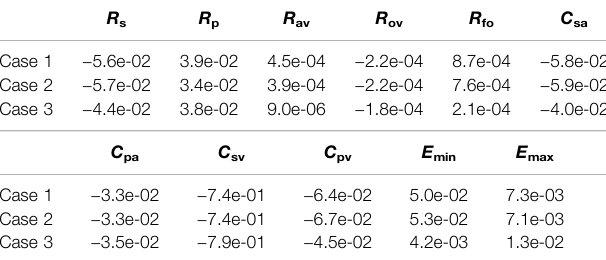
TABLE 4 | Sensitivities for cases 1, 2, and 3 computed for the systemic venous pressure.